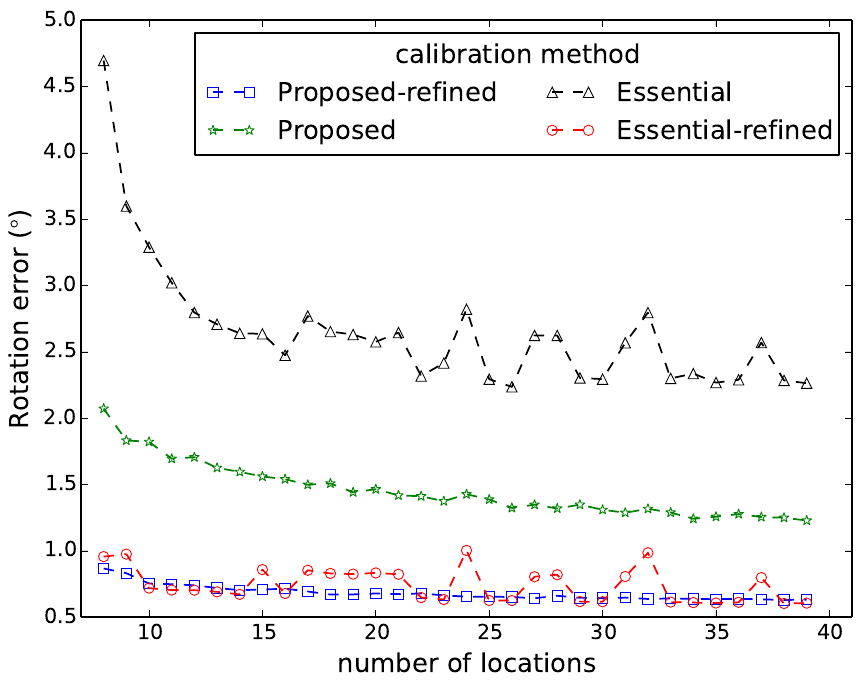
Figure 10. Rotation error comparison between our method (proposed) and the method of Hödlmoser et al. [17] (essential) using different numbers of locations. Each location yields two calibration samples (head and